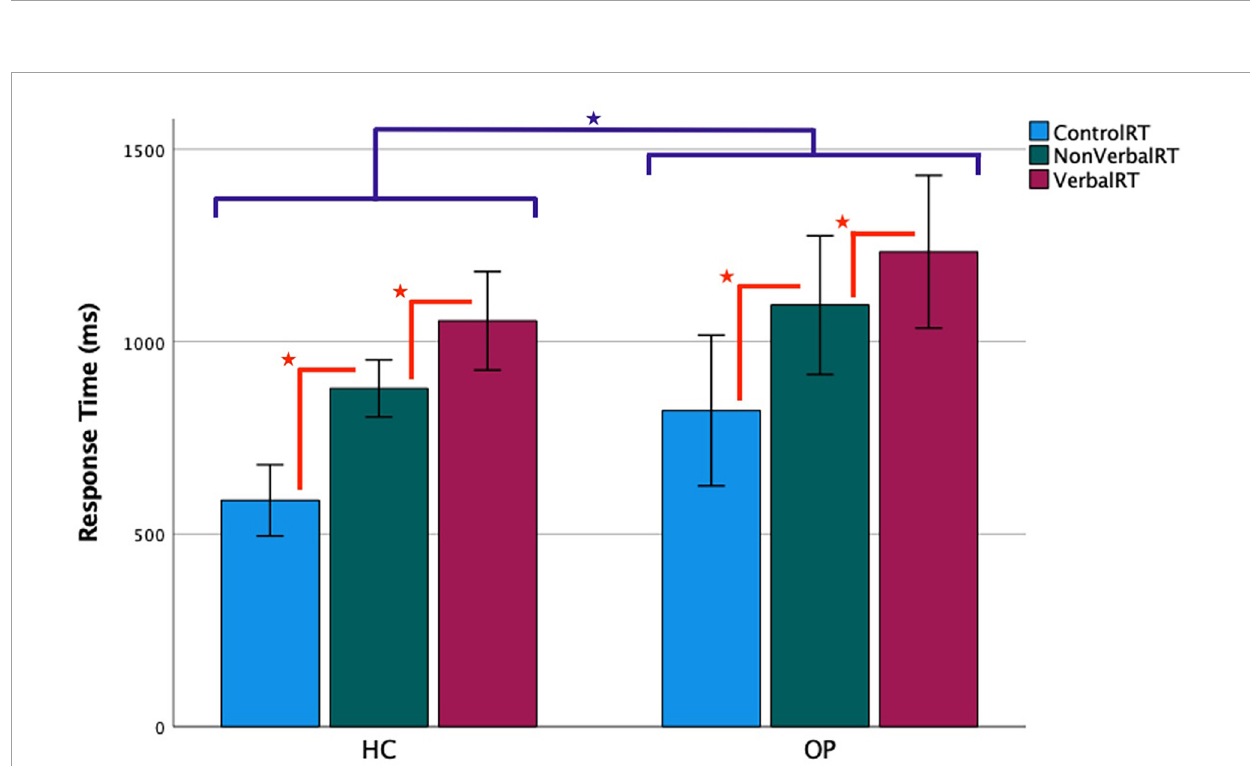
FIGURE3 Functional magnetic resonance imaging task response time by group. Accurate trials only were included in the analysis. Error bars represent a 95% confidence interval of the true mean. = the OP group’s RTs were slower than the HC group’s, p < 0.05. = RTs progressively increased from control to non-verbal to verbal conditions, all p <